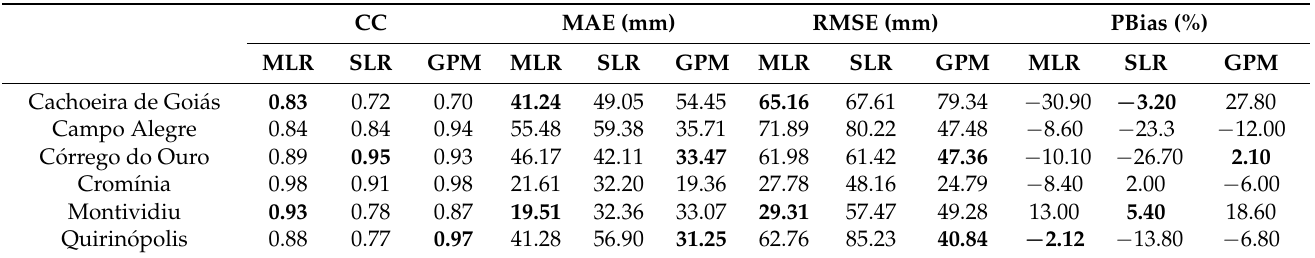
Table 3. Performance indexes of the three methods for filling monthly missing data at the target sites. CC MAE (mm) RMSE (mm) PBias